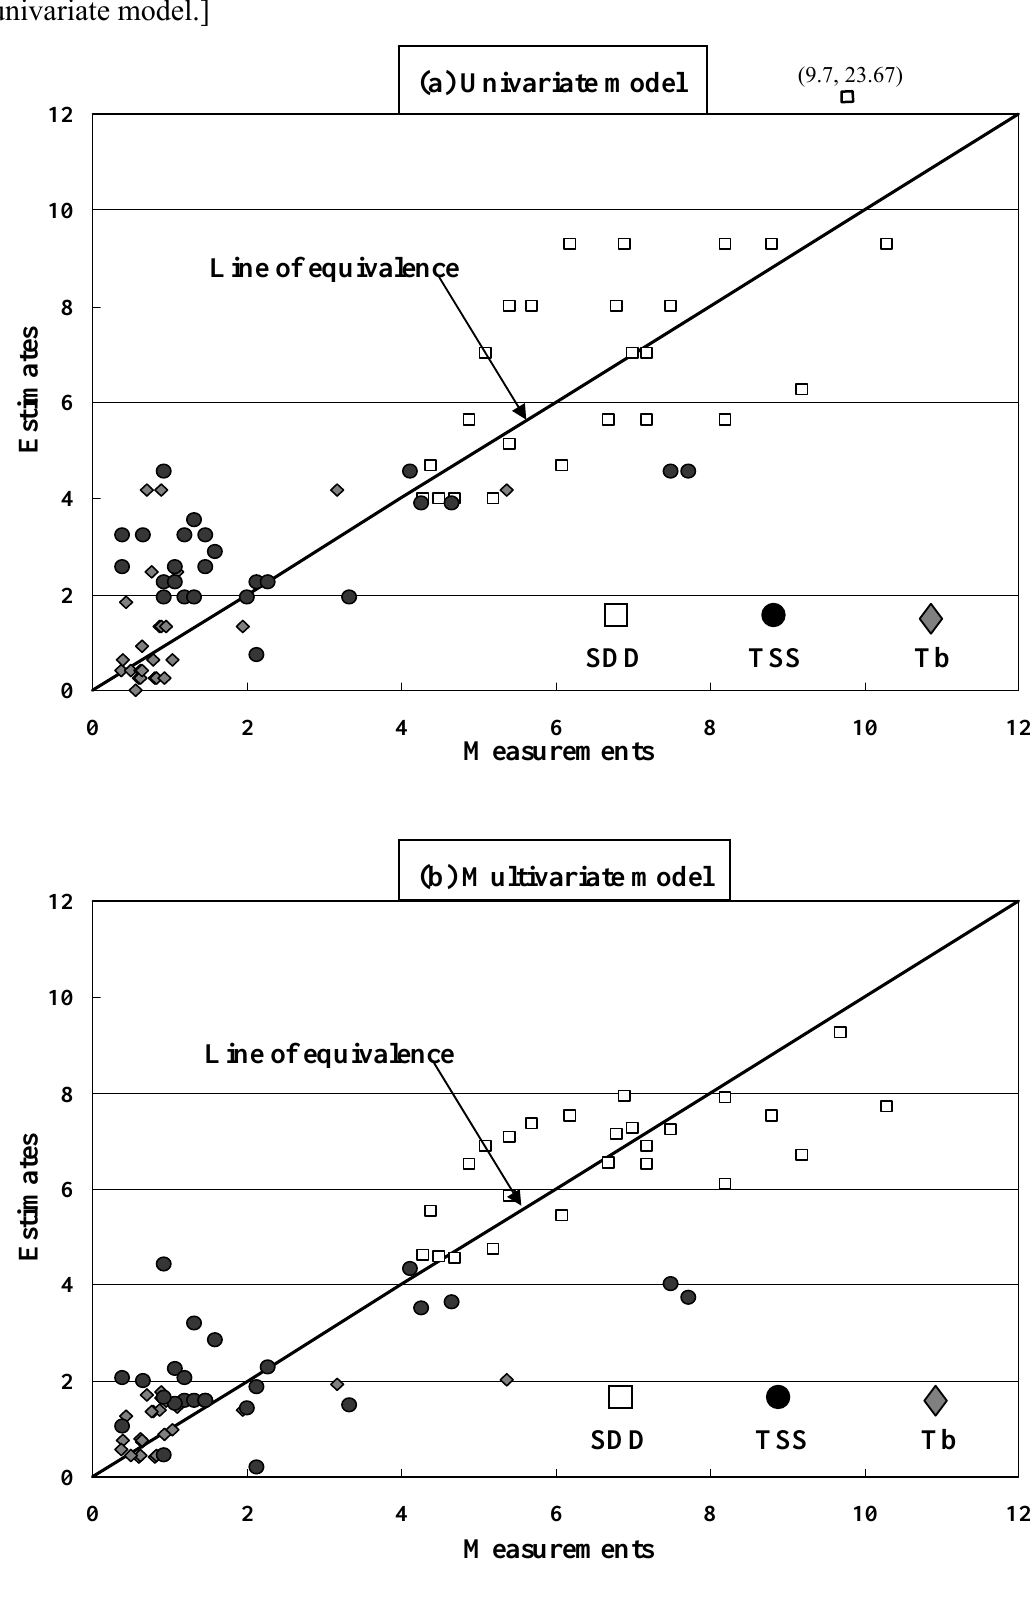
Figure 7. Water quality measurements versus estimates using the univariate and multivariate estimation models. [Note that there is an out-of-bound SDD estimate by the univariate